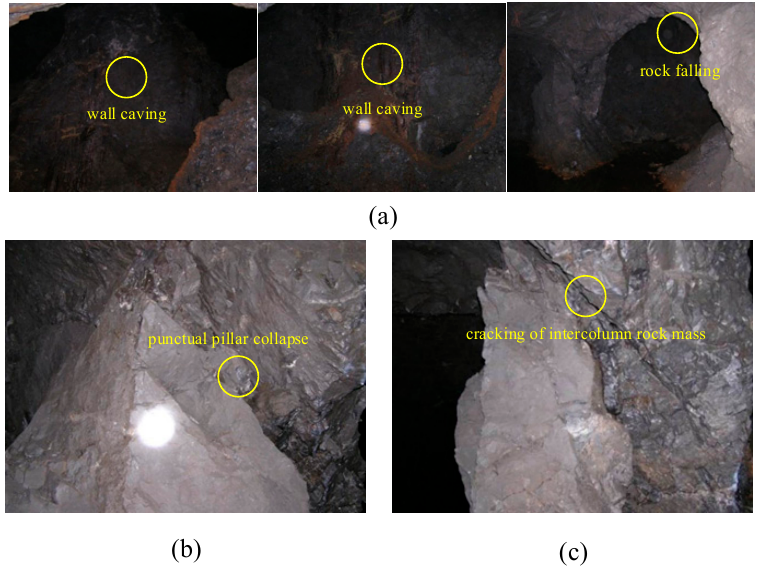
Figure 3. Underground instability and failure phenomena of the mine. ( a ) Underground surrounding rock caving and caving; ( b )—70 m horizontal 306 stope point column falling across; ( c )—120 middle section 410 and 412 stope column rock mass cracking.